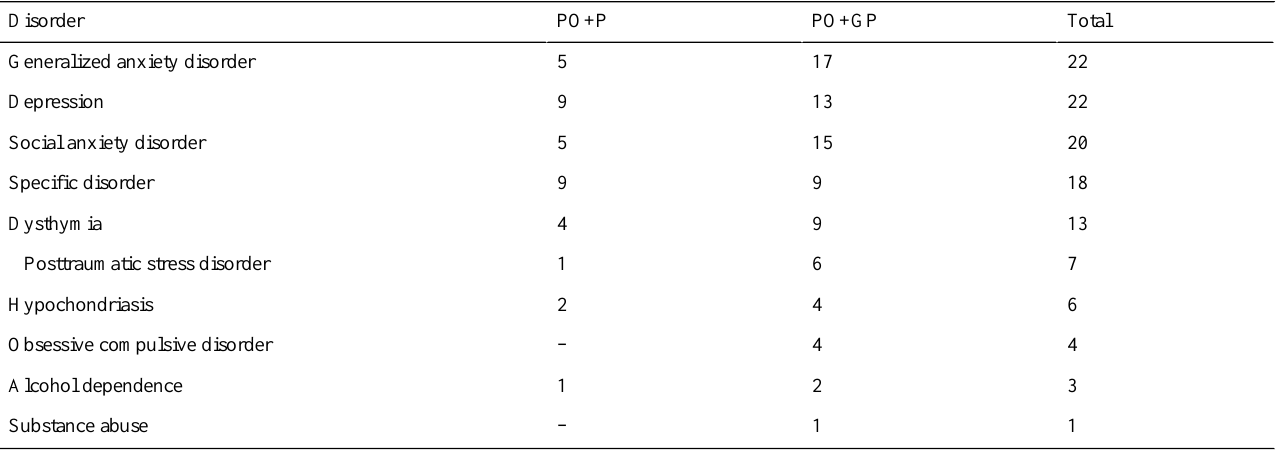
Table 3. Clinical comorbid condition frequencies at pretreatment assessment, by group*